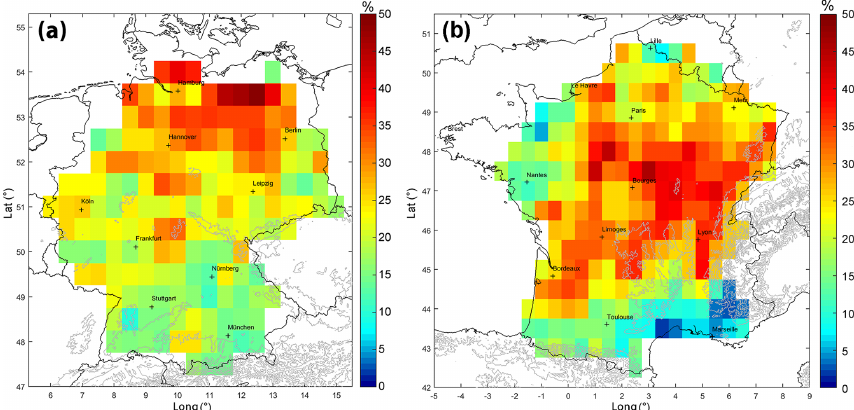
Figure 4. Share of frontal SCSs (relative to all SCSs; r ≤ 200km) over (a) Germany and (b) France for 0.5 ◦ × 0.5 ◦ (SHY of 2005–2014). Grid points containing less than 50 SCS tracks (see Fig. 1) were left white. Please note that the cities in this figure are presented in their local